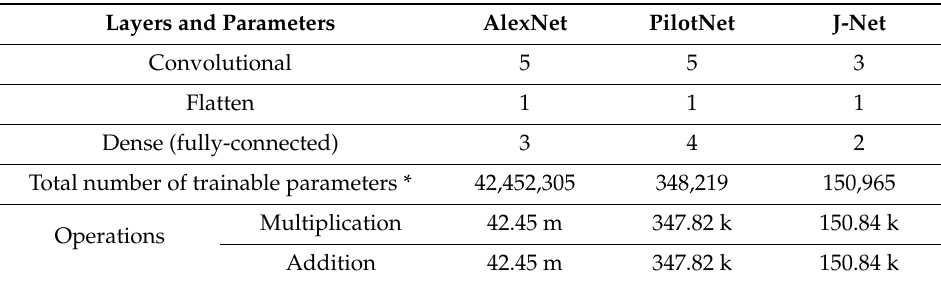
Table 2. Layers and number of trainable parameters for J-Net, PilotNet, and AlexNet. Layers and Parameters AlexNet